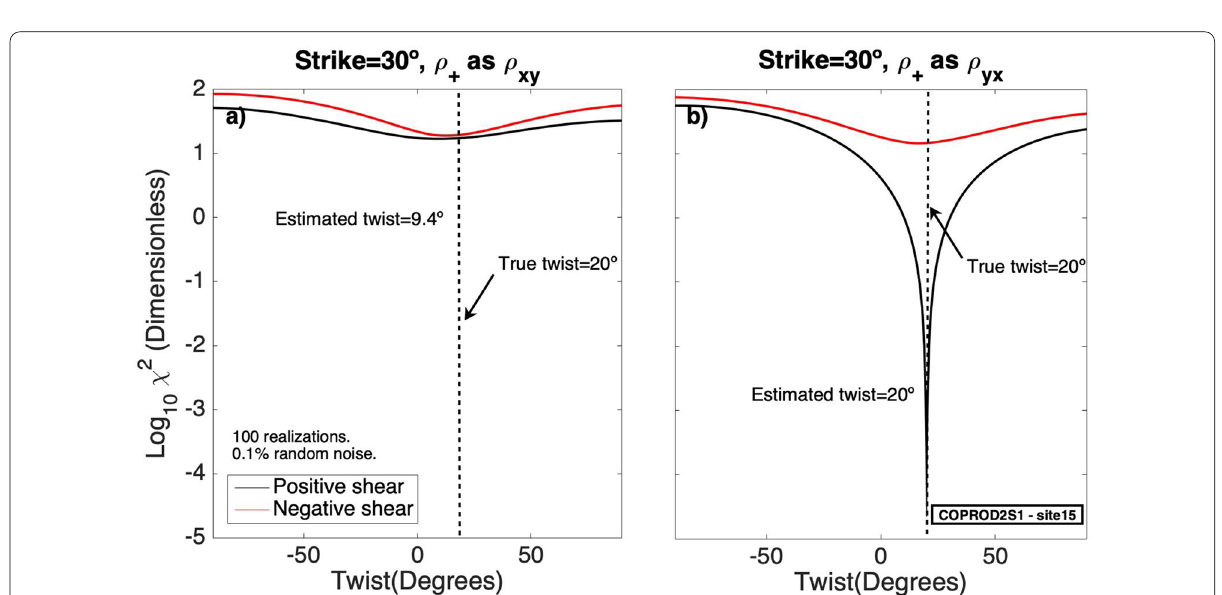
Fig. 6 χ 2 objective functions for the estimation of twist assuming the two possibilities for the unknown sign of shear. The black lines in a and b represent the functions for positive shear and the red lines for negative value. The lowest minimum corresponds to the correct positive shear and the correct assumption, i.e., ρ as ρ +